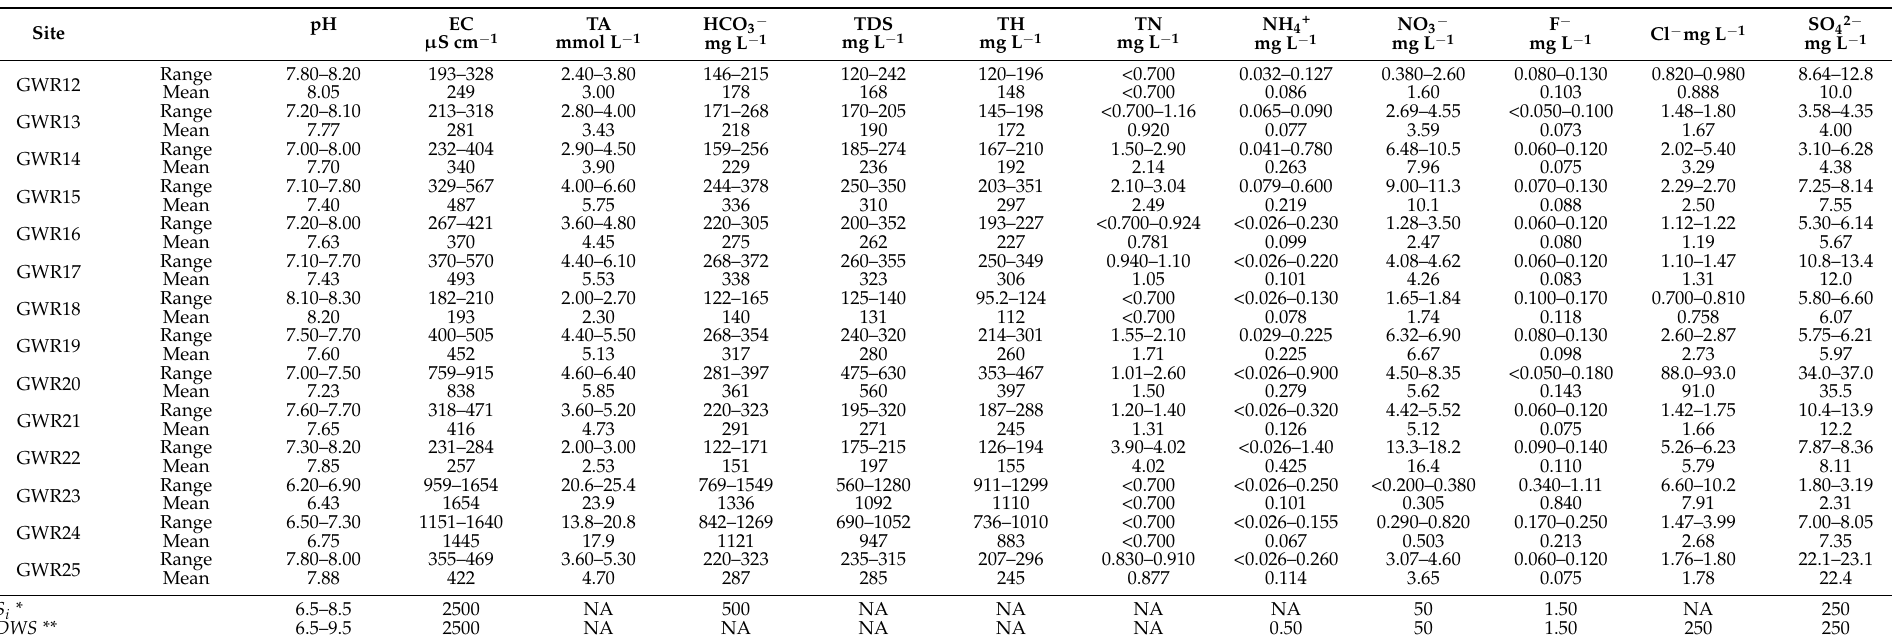
Table 3. Range and mean values of pH, electrical conductivity (EC), total alkalinity (TA), HCO 3 − , total dissolved solids (TDS), total hardness (TH), total nitrogen (TN), NH 4+ , NO 3 − , F − , Cl − and SO 42 − in karst